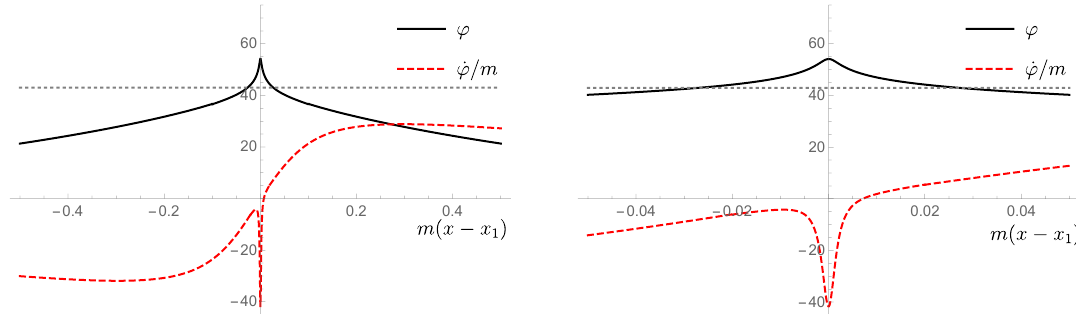
Figure 12. Bounce solution describing tunneling from the Unruh vacuum far away from the BH. Left: profiles of the bounce (black solid) and its time derivative (red dashed) at t = 0 for λ = 0 . 87Λ U 1 , where Λ is defined in eq. (5.25). Right: zoom-in on the central region of the left plot. We take U 1 √ ln( m/ κ ) = 20 . The grey dotted line marks the field value ϕ max at the maximum of the potential barrier, see figure